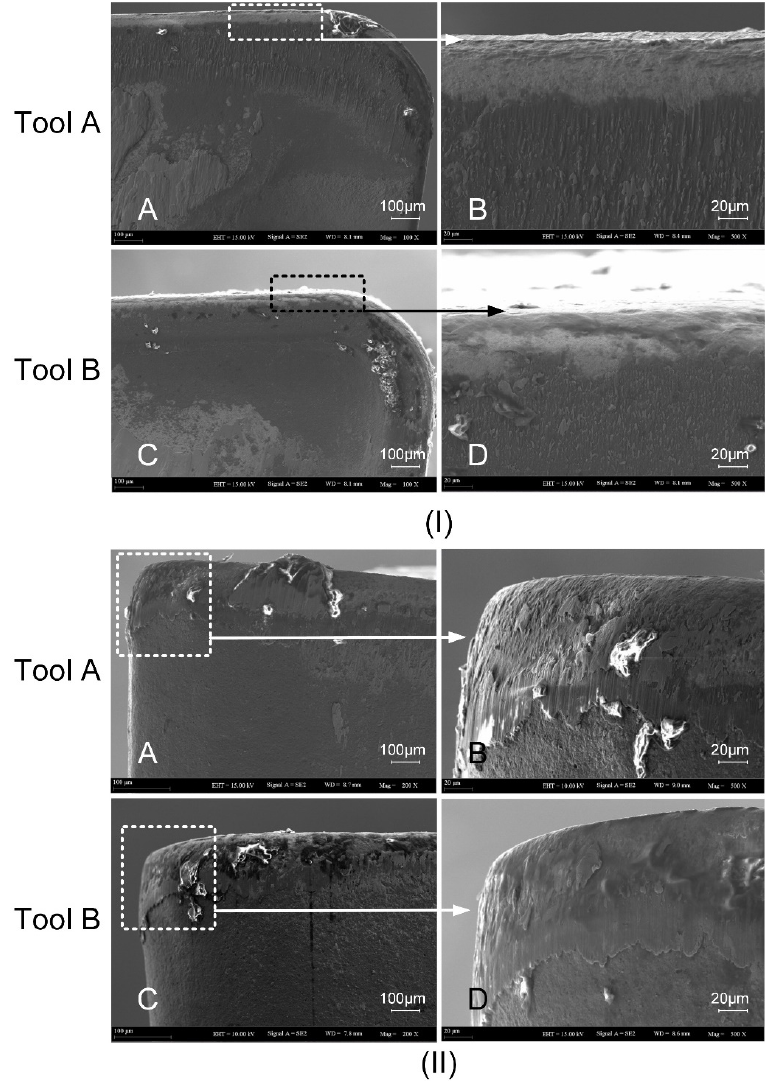
Figure 10. ( I ) SEM diagram of Tool A and Tool B wear on the rake face. ( II ) SEM diagram of Tool A and Tool B wear on the flank face.